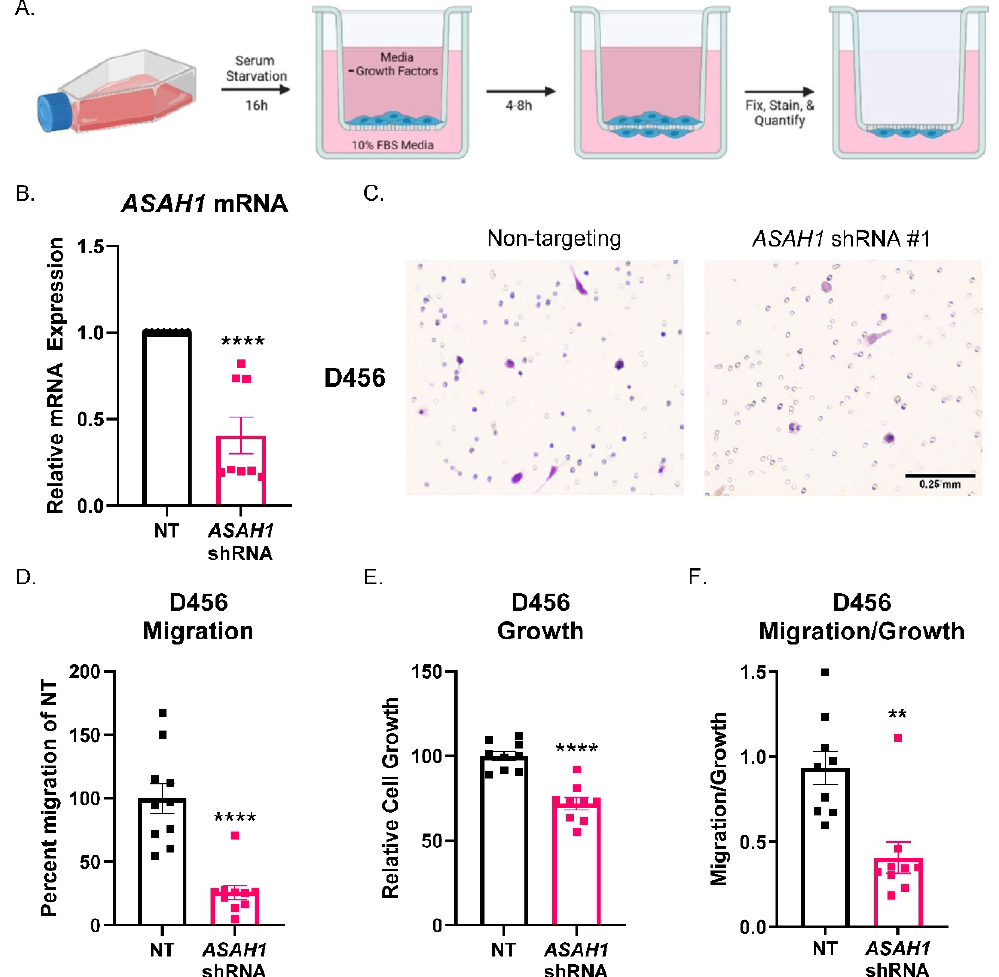
Figure 3. ASAH1 knockdown decreased migration of D456 cells. Cells were transduced with either non-targeting (NT) control or ASAH1 shRNA. After 48 h, the cells were plated at 50,000 cells/insert for the Boyden chamber migration assay with 10% FBS as a chemoattractant, 5000 cells/well for growth assay, and the remaining for RNA. ( A ) Schematic showing Boyden chamber assay steps. ( B ) mRNA expression of ASAH1 at time of assay normalized to β - Actin using ∆∆CT. ( C ) Representative images of D456 migration inserts with crystal violet staining for non-targeting and ASAH1-directed shRNA constructs. ( D ) Migration inserts were imaged with 6 images at 10× magnification/insert and quantified using particle analysis in ImageJ and normalized to the NT control. ( E ) Matching growth was analyzed by Cell Titer Glo and normalized to NT control. ( F ) Percent migration was divided by the relative cell growth to determine the ratio of migration to growth. Data from three independent experiments were combined and analyzed using independent t -test ( n = 3–4 per experiment). Data are displayed as means ± SEM. ** p <0 .01, **** p < 0.0001.